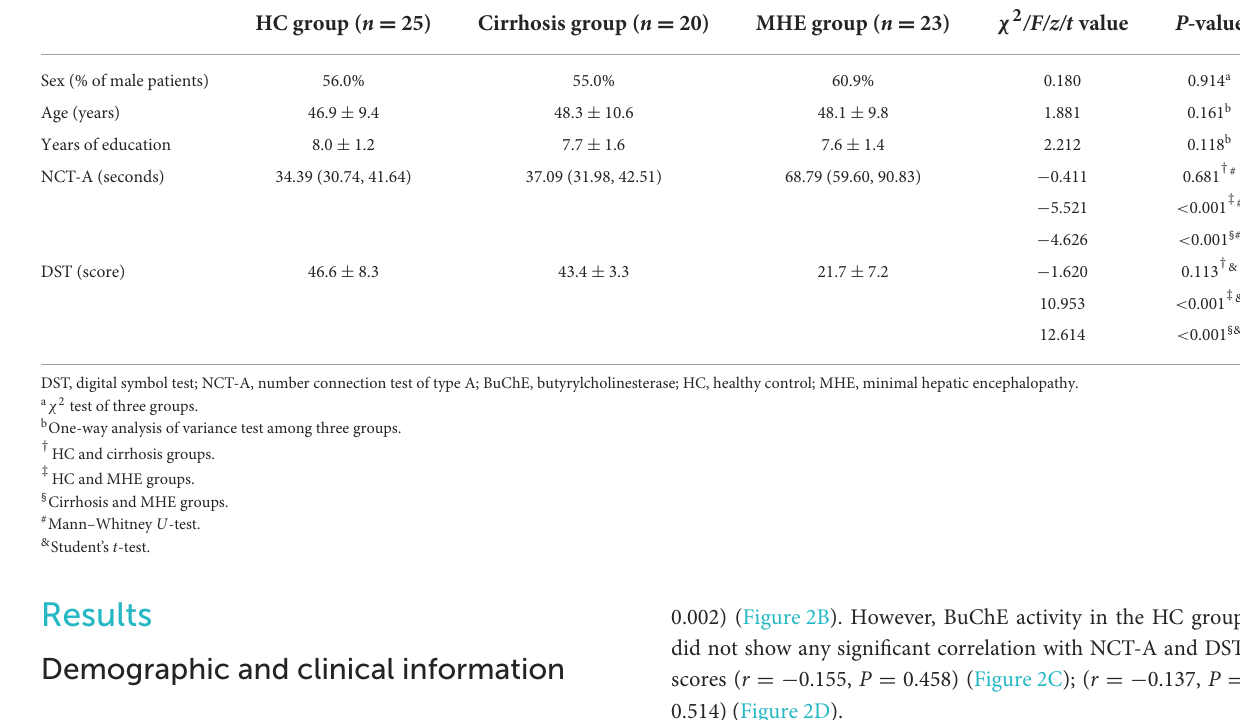
TABLE 1 Demographic and physiologic data of the studied